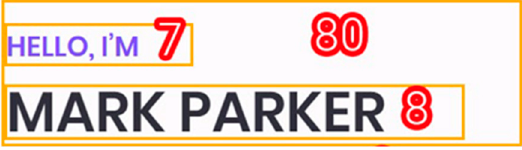
Figure 6. Example of block variations.